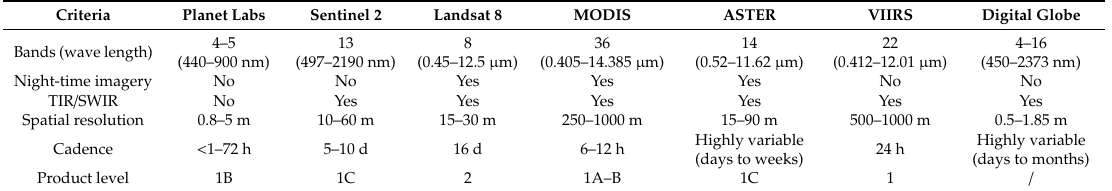
Table 1. Characteristics of optical satellite instruments currently used for volcano